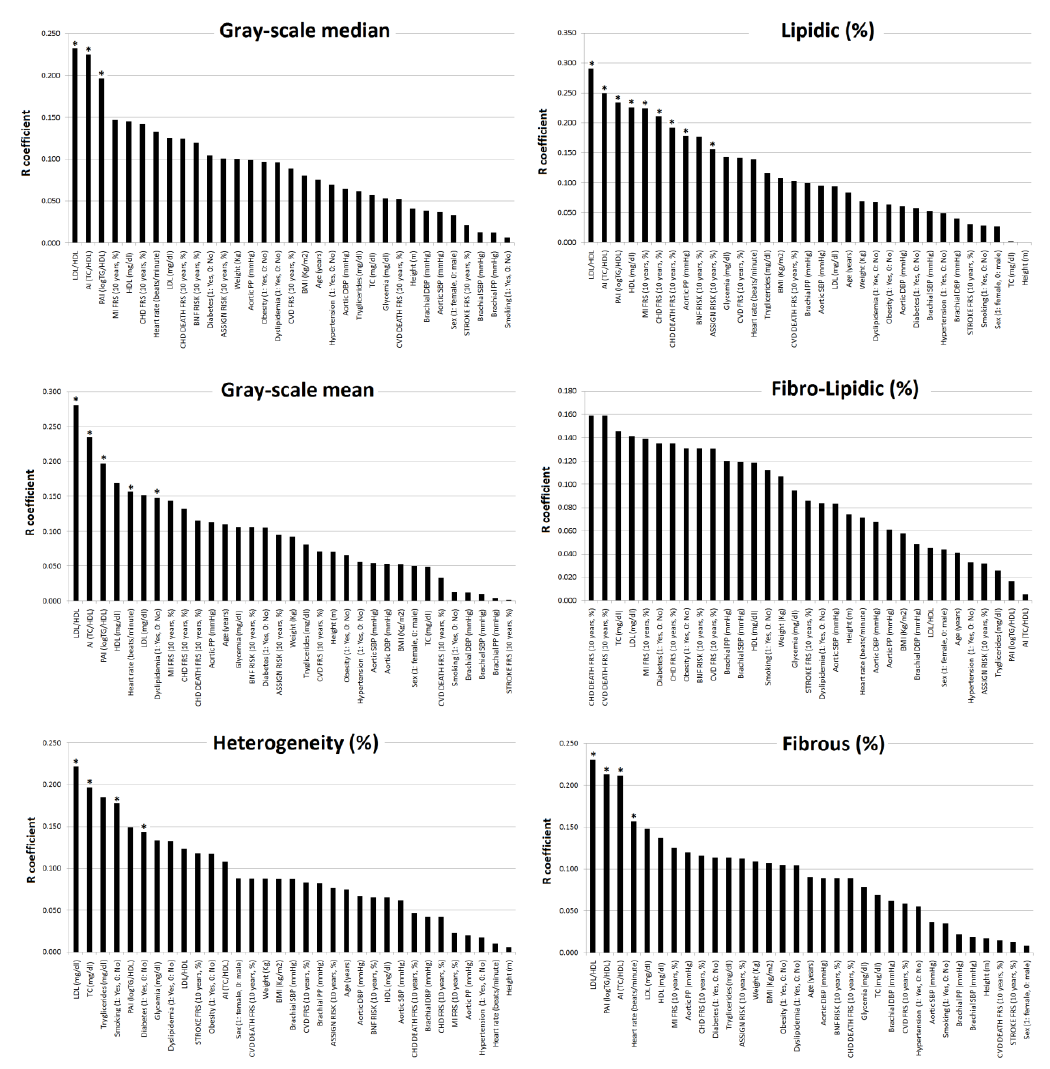
Figure 4. Strength of association (correlation coefficient absolute value, R) between subjects´ characteristics and plaque composition ( n = 206). * p <